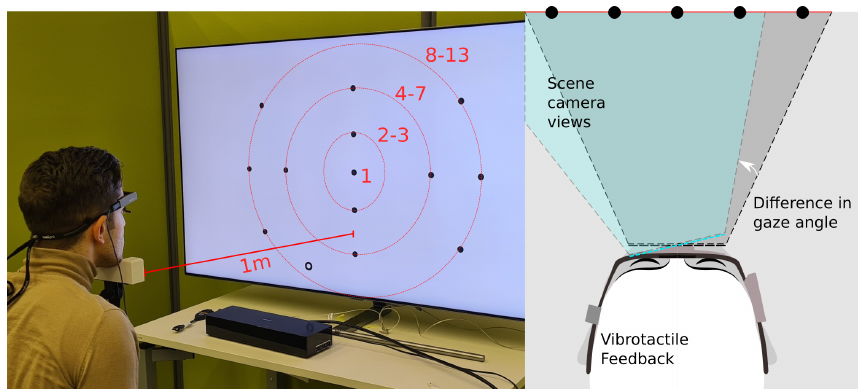
Figure 1. Left: study setup with participant. All red markups were not visible for the participant. The distribution of the markers was adapted from Thibeault et al. (2019). Right: the scene camera view, shown as the highlighted area between the participant and markers, represents the room of all available gaze angles. Diagonal lines in black and blue show examples of a tilted level of the glasses.